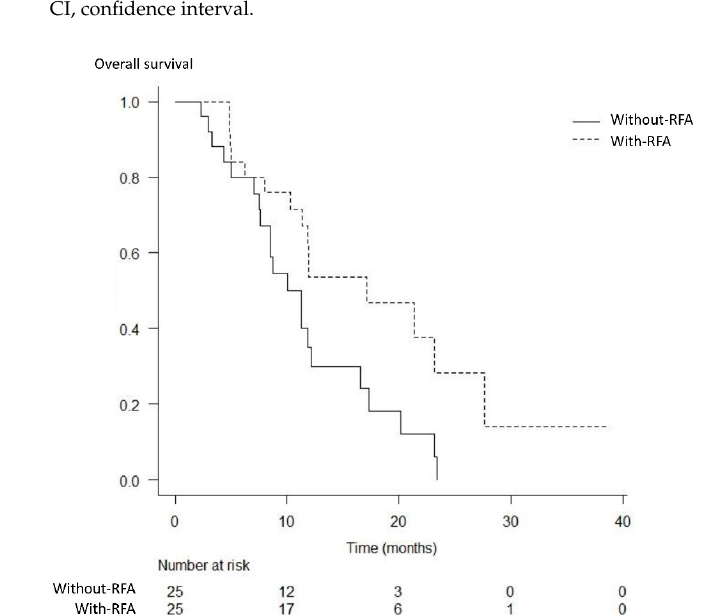
Figure 3. Kaplan–Meier analysis of the overall survival. The median overall survival was significantly higher in the with-RFA group than that in the without-RFA group (17.1 months versus 11.3 months, p = 0.017).